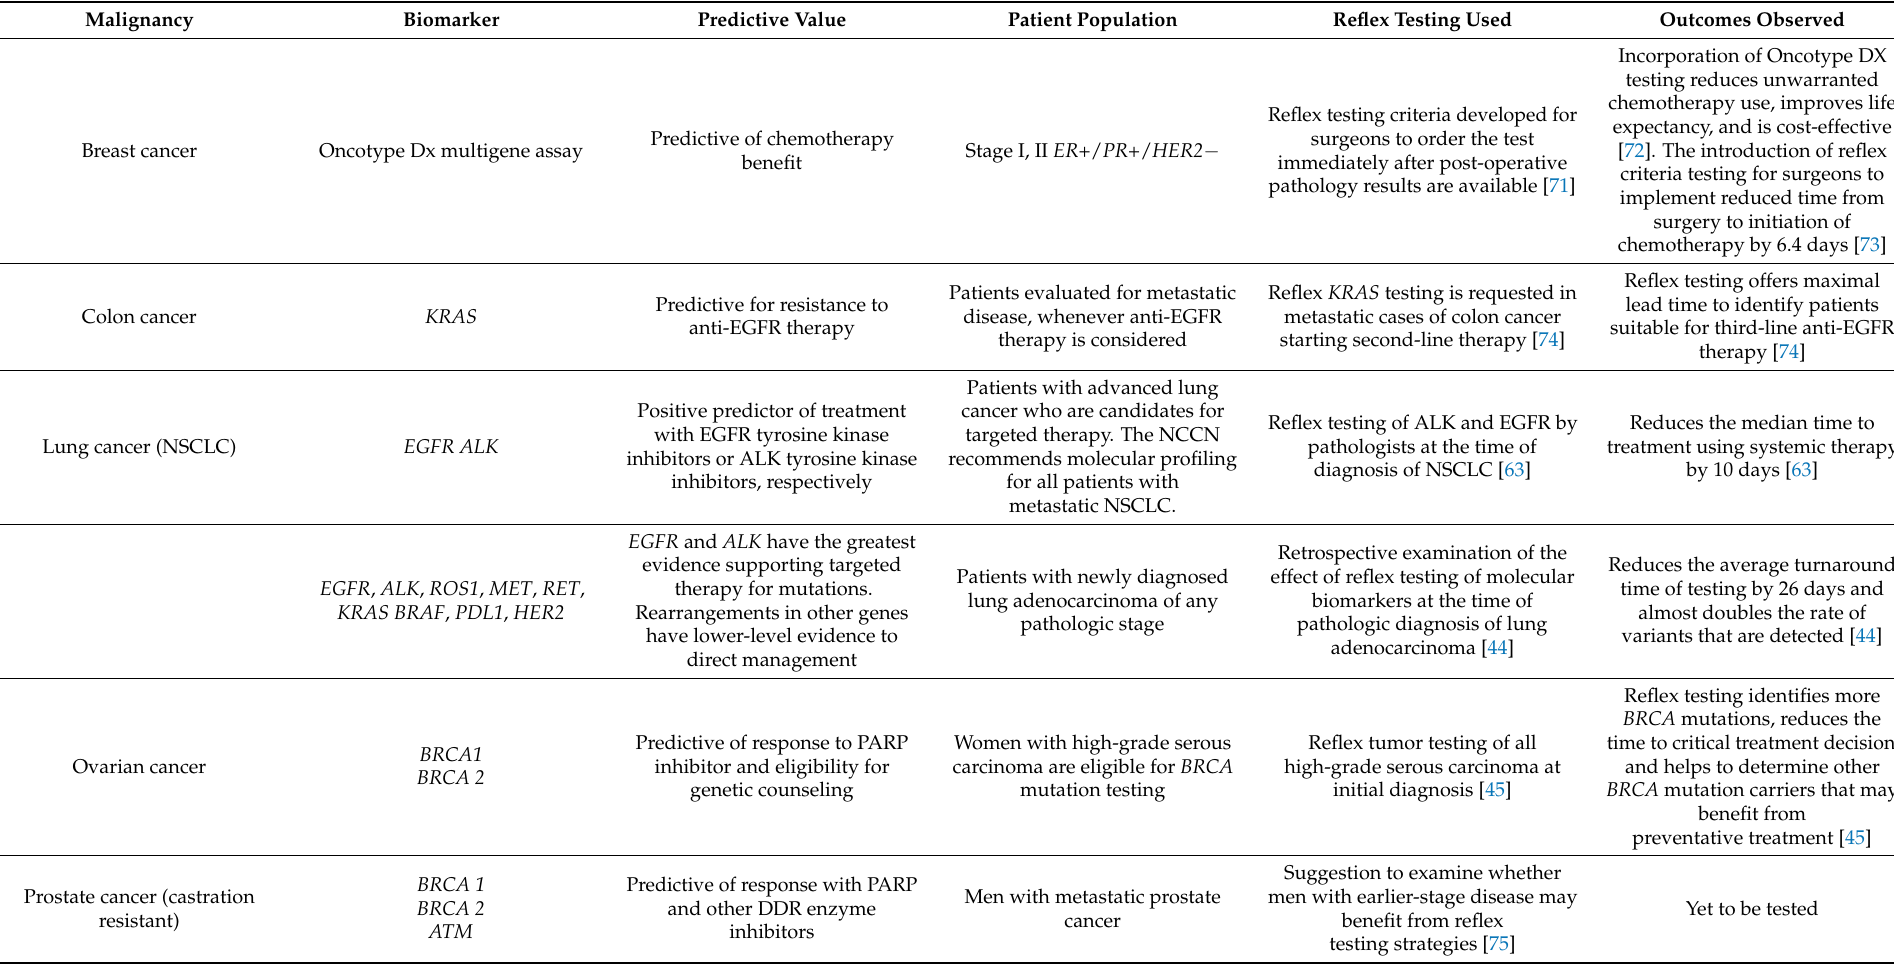
Table 3. Roles of predictive biomarkers in various types of cancer. Those presented below have studies examining the effect of reflex testing on direct management options (primarily targeted therapy). Biomarker and predictive values were adapted from El-Deiry et al. [70]; other sources used are cited directly in text. DDR, DNA damage response; EGFR, epidermal growth